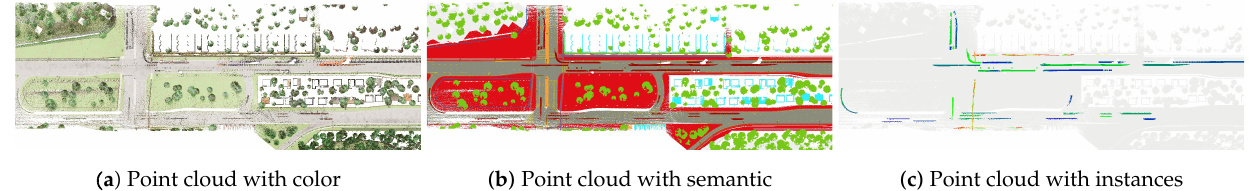
Figure A4. CARLA Training set . From top to bottom: T 2 , T 3 , T 4 , T 5 (synthetic data). Figure A4. CARLA training set. From top to bottom : T 2 , T 3 , T 4 , T 5 (synthetic data).